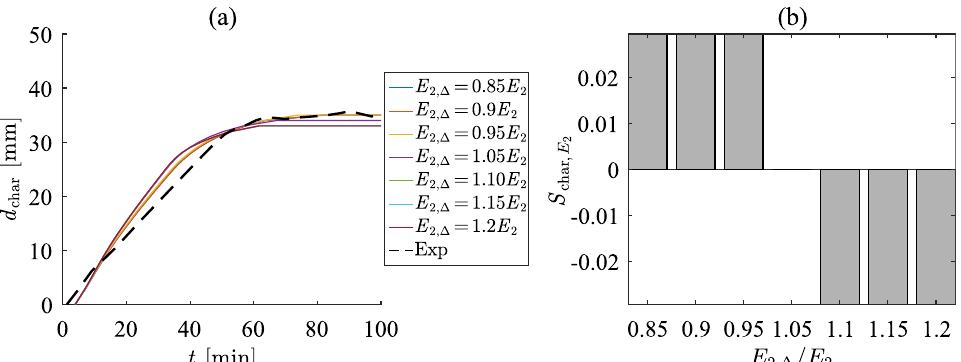
Fig. 4 a The development of charring depth for varied parameter E 2, (cid:31) . b Sensitivity index S char, E charring depth